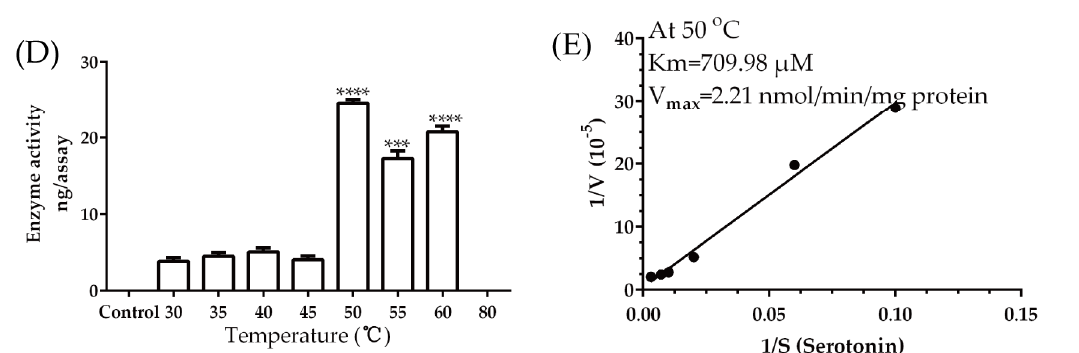
Figure 4. Characterization of the enzymatic activity of xoSNAT3. ( A ) Expression of GST-xoSNAT3 and GST tagged proteins in E. coli by IPTG. ( B ) Western blot analysis of purified GST-xoSNAT3 and GST. ( C ) Purification of GST-xoSNAT3 and GST. ( D ) Analysis of the enzymatic activity of GST- xoSNAT3 at different temperatures. ( E ) Determination of K m and V max values of GST-xoSNAT3 using serotonin as the substrate. The expression of GST-xoSNAT3 in E. coli was induced by the addition of IPTG (0.4 mM) at 16 ◦ C for 16 h. GST-xoSNAT3 (1 µ g) was incubated with serotonin (0.5 mM) at different temperatures, the serotonin and product were both determined by LC-MS/MS. Control means enzymatic activity of 100 µ L reaction buffer (0.5 mM serotonin, 0.5 mM acetyl-CoA and 100 mM potassium phosphate, pH = 8.8) in the absent of GST-xoSNAT3. The mixture was incubated at 30 ◦ C for 30 min, and analyzed by HPLC. The K m and V max values of GST-xoSNAT3 were determined by using Lineweaver-burk plots. Red arrow means the target protein. Asterisks indicate statistically significant differences determined using Student’s t -test (*** p < 0.001; **** p <